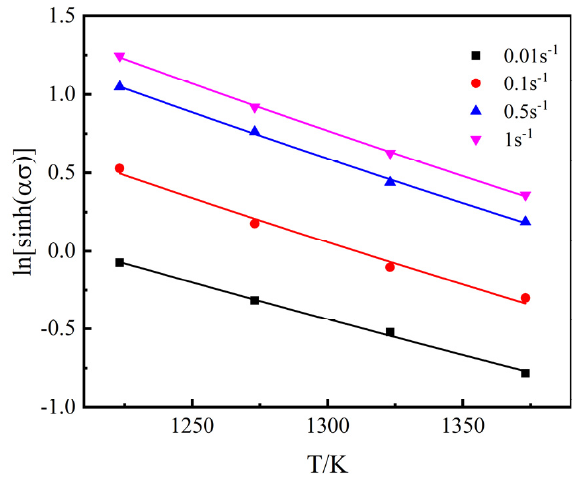
Figure 8. Fitting line, ln [ sinh ( ασ )] vs. T.